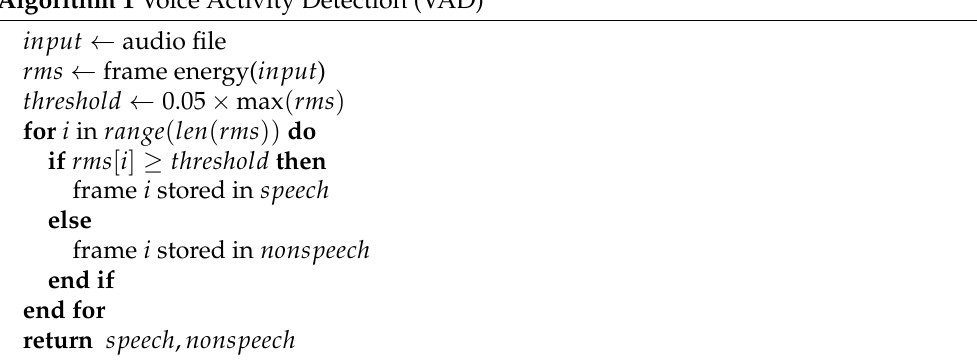
Algorithm 1 Voice Activity Detection